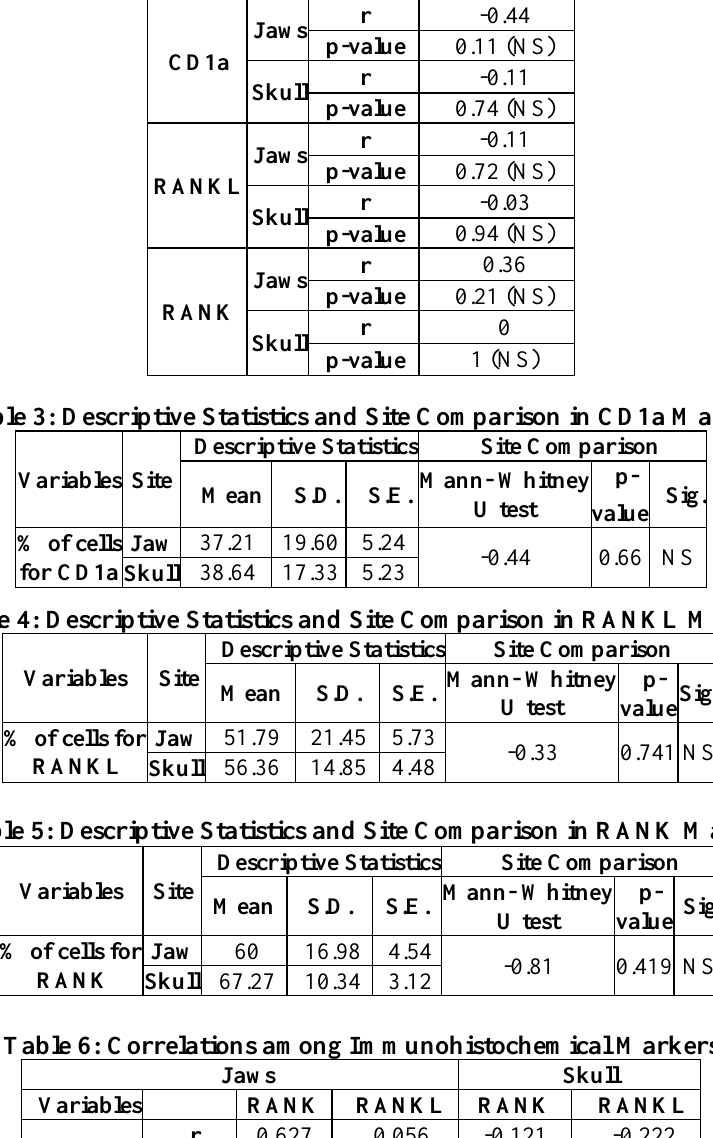
Table 2: Relation between the Variables in CD1a, RANKL and RANK in the Jaws and Skull Markers Site % of cells No. of mitoses